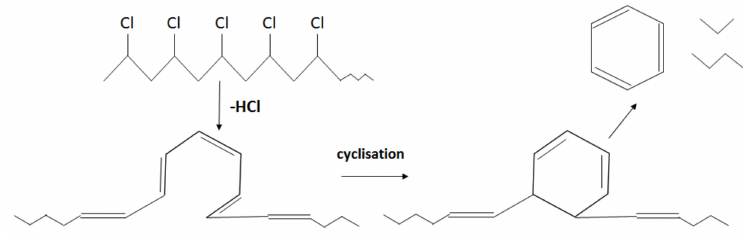
Figure 4. Schematic cyclisation reaction during PVC pyrolysis (adapted from